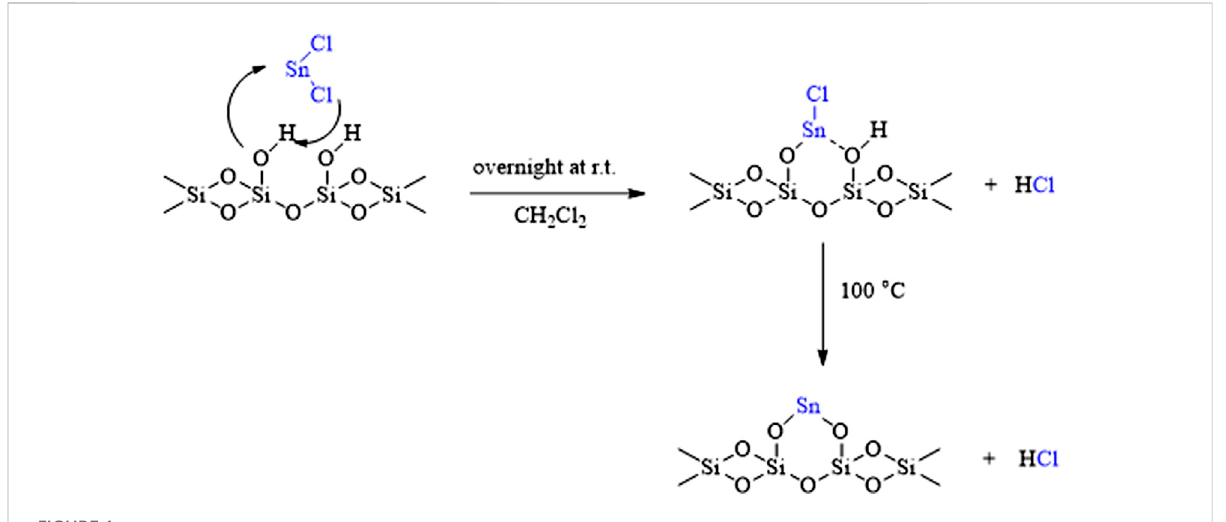
FIGURE 1 Chemical description of catalyst